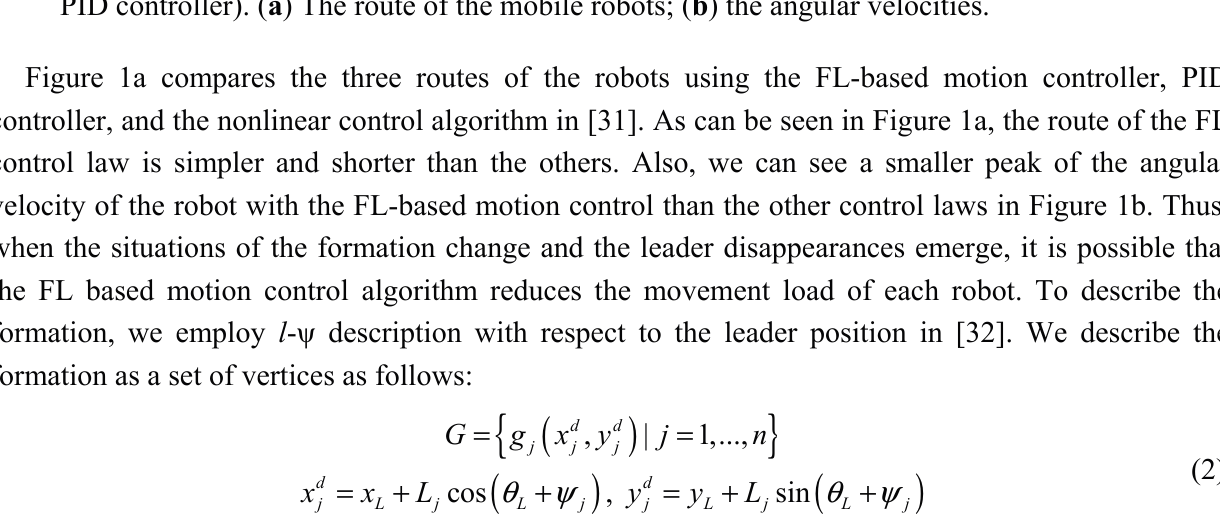
Figure 1. The comparison of the movement loads of the proposed feedback linearization algorithm and the others ( ☆ : the proposed algorithm, ∆ : the nonlinear controller, and □ : PID controller). ( a ) The route of the mobile robots; ( b ) the angular